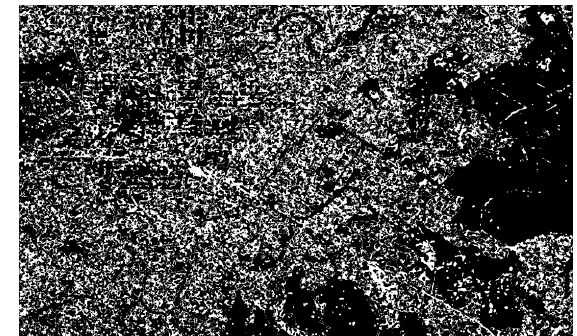
Figure 8. Black: A1L, A2L, C1L, C2L; white: background (all other combinations)